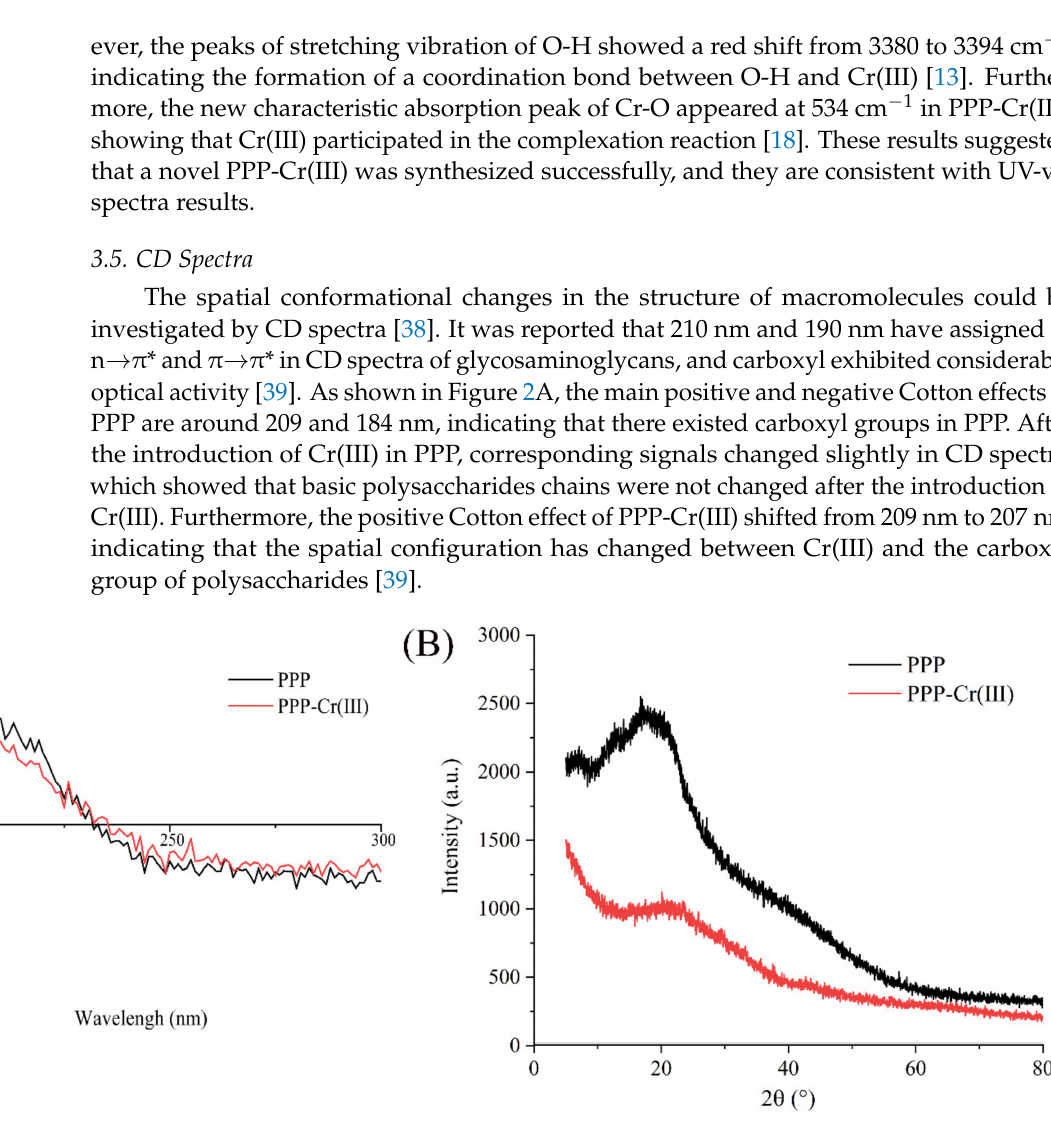
Figure 2. CD spectra ( A ), XRD pattern ( B ) of PPP and